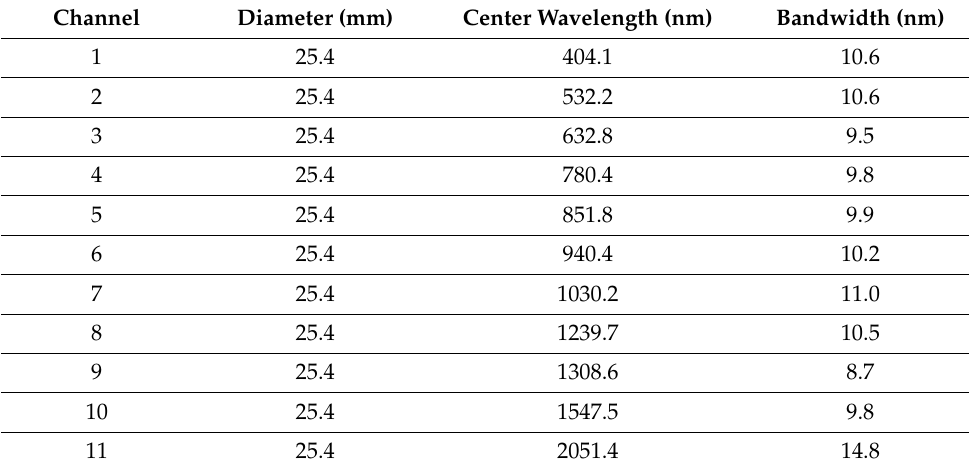
Table 2. Design parameters of 11